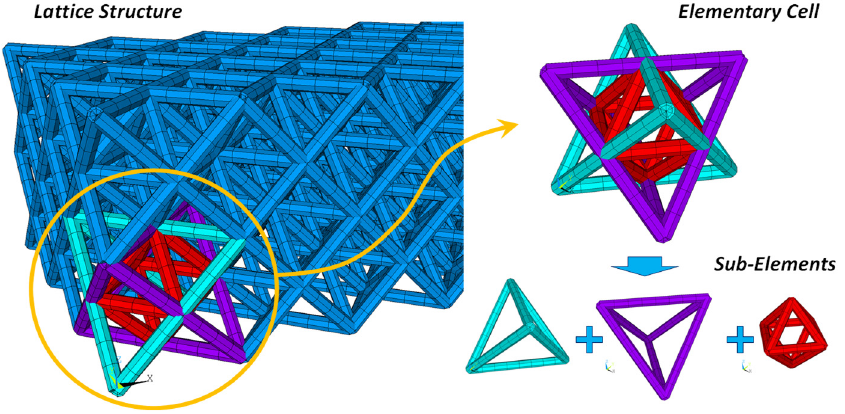
Figure 1. Finite element model of the lattice structure with octet-truss unit cell.